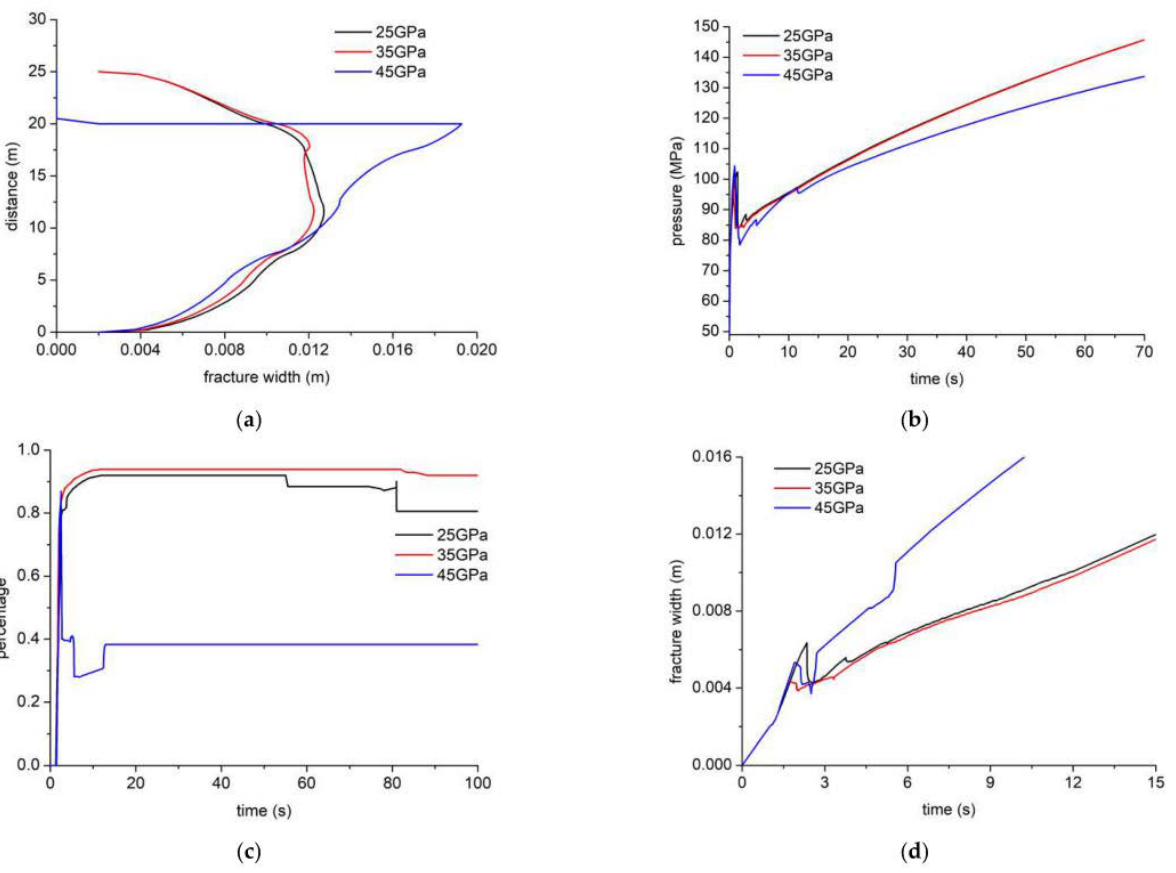
Figure 15. Fracture parameter under elastic modulus: ( a ) HF width; ( b ) pressure; ( c ) ratio of tensile failure; and ( d ) maximum HF